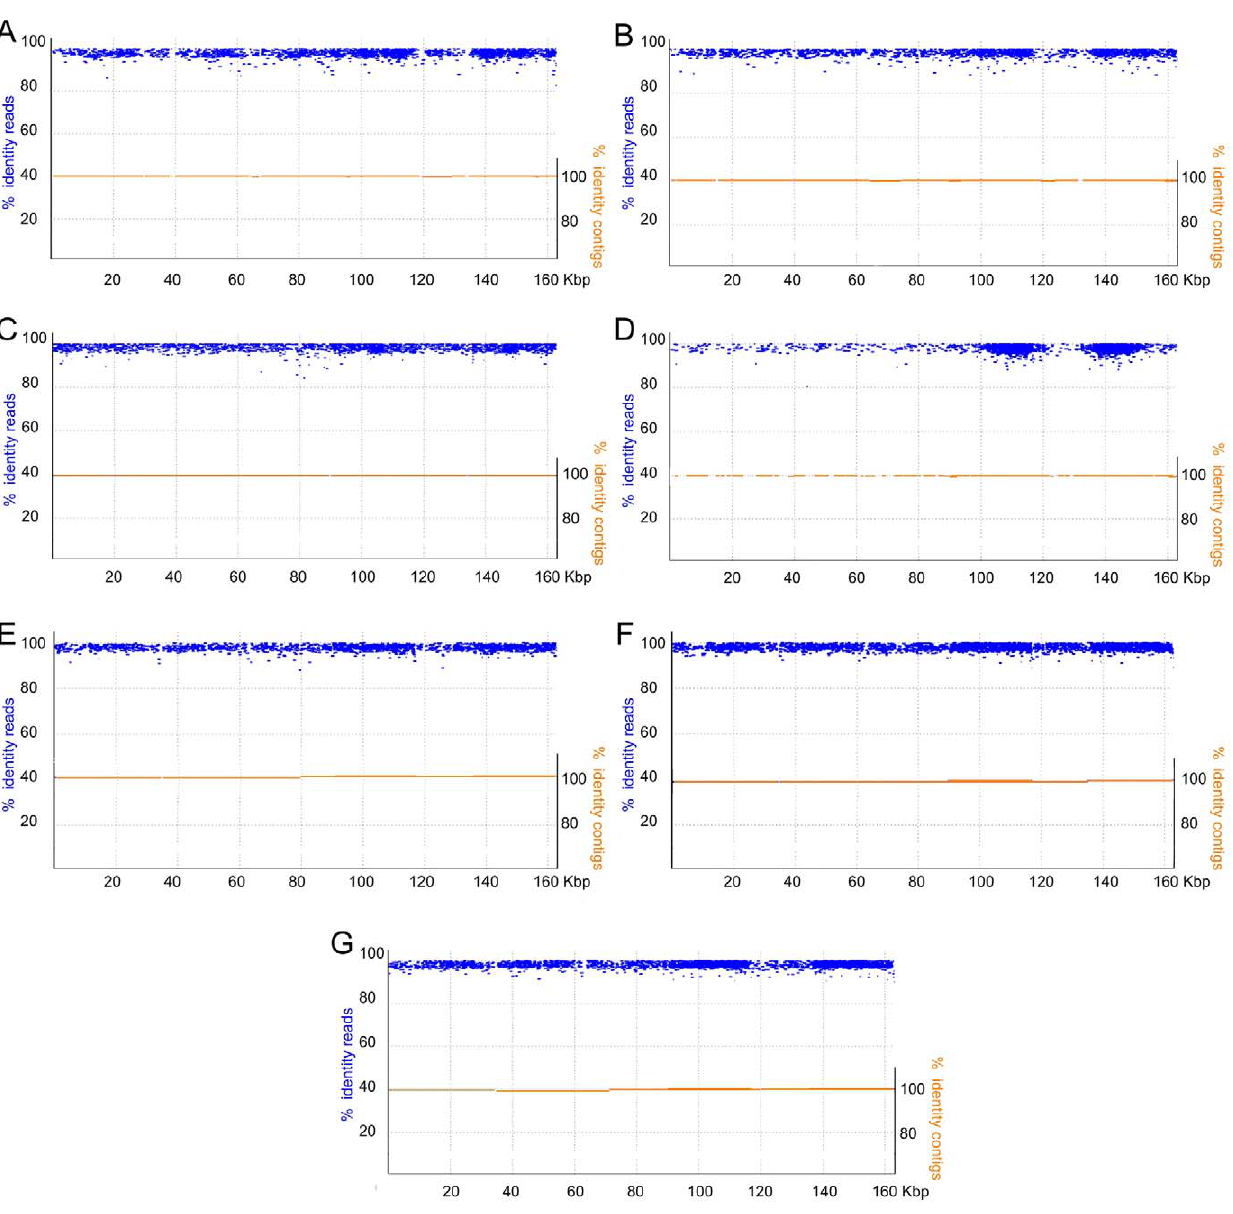
Figure 3. Draft assemblies of the chloroplast genomes of 7 castor bean accessions. Assembled contigs corresponding to the chloroplast genomes of the different accessions are shown in orange, mapped to the reference v. Hale chloroplast genome (x-axis). Individual reads are shown in blue, aligned to the same reference genome. Left y-axis corresponds to the percent identity of each read relative to the reference cv. Hale sequence. Right y-axis shows the percent identity of contig relative to the Hale sequence. Each panel corresponds to a different cultivar: A) US Virgin Islands, B) El Salvador, C) Puerto Rico, D) India, E) Ethiopia, F) Greece, and G) Mexico.